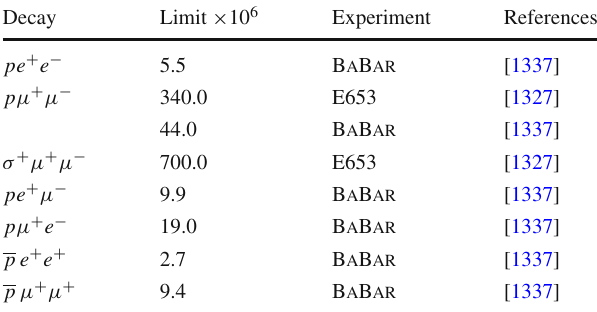
Table 303 Upper limits at 90% C.L. for Λ + c